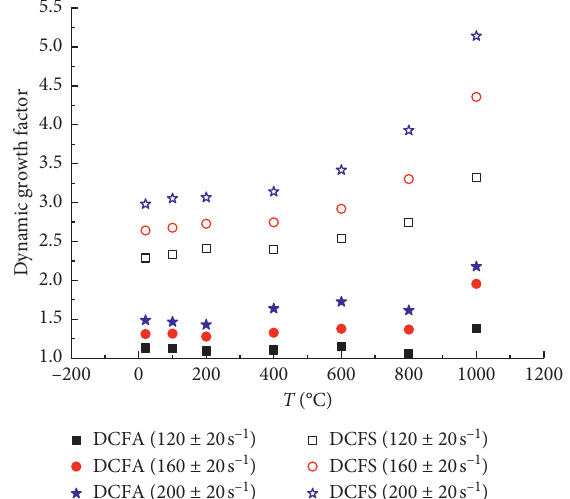
Figure 9: Relationship between dynamic increase factor and temperature.